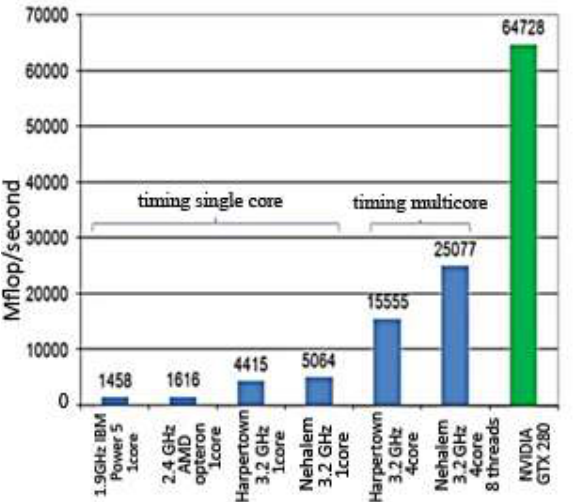
Figure 6. Performance of different CPUs and GPUs[24]